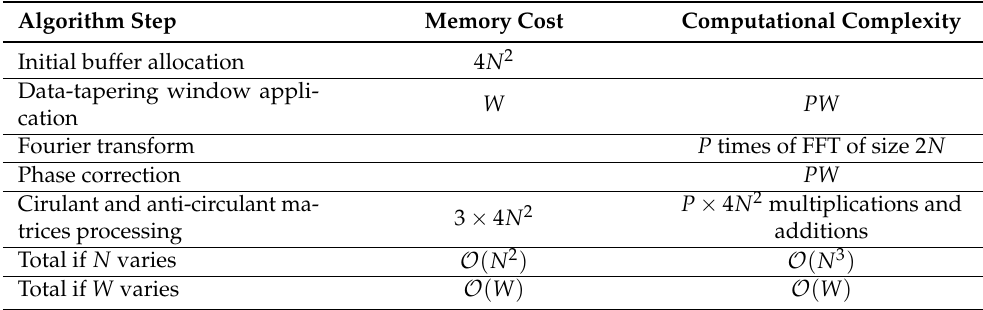
Table 2. Memory cost and computational complexity of the main steps in the 2N-FFT